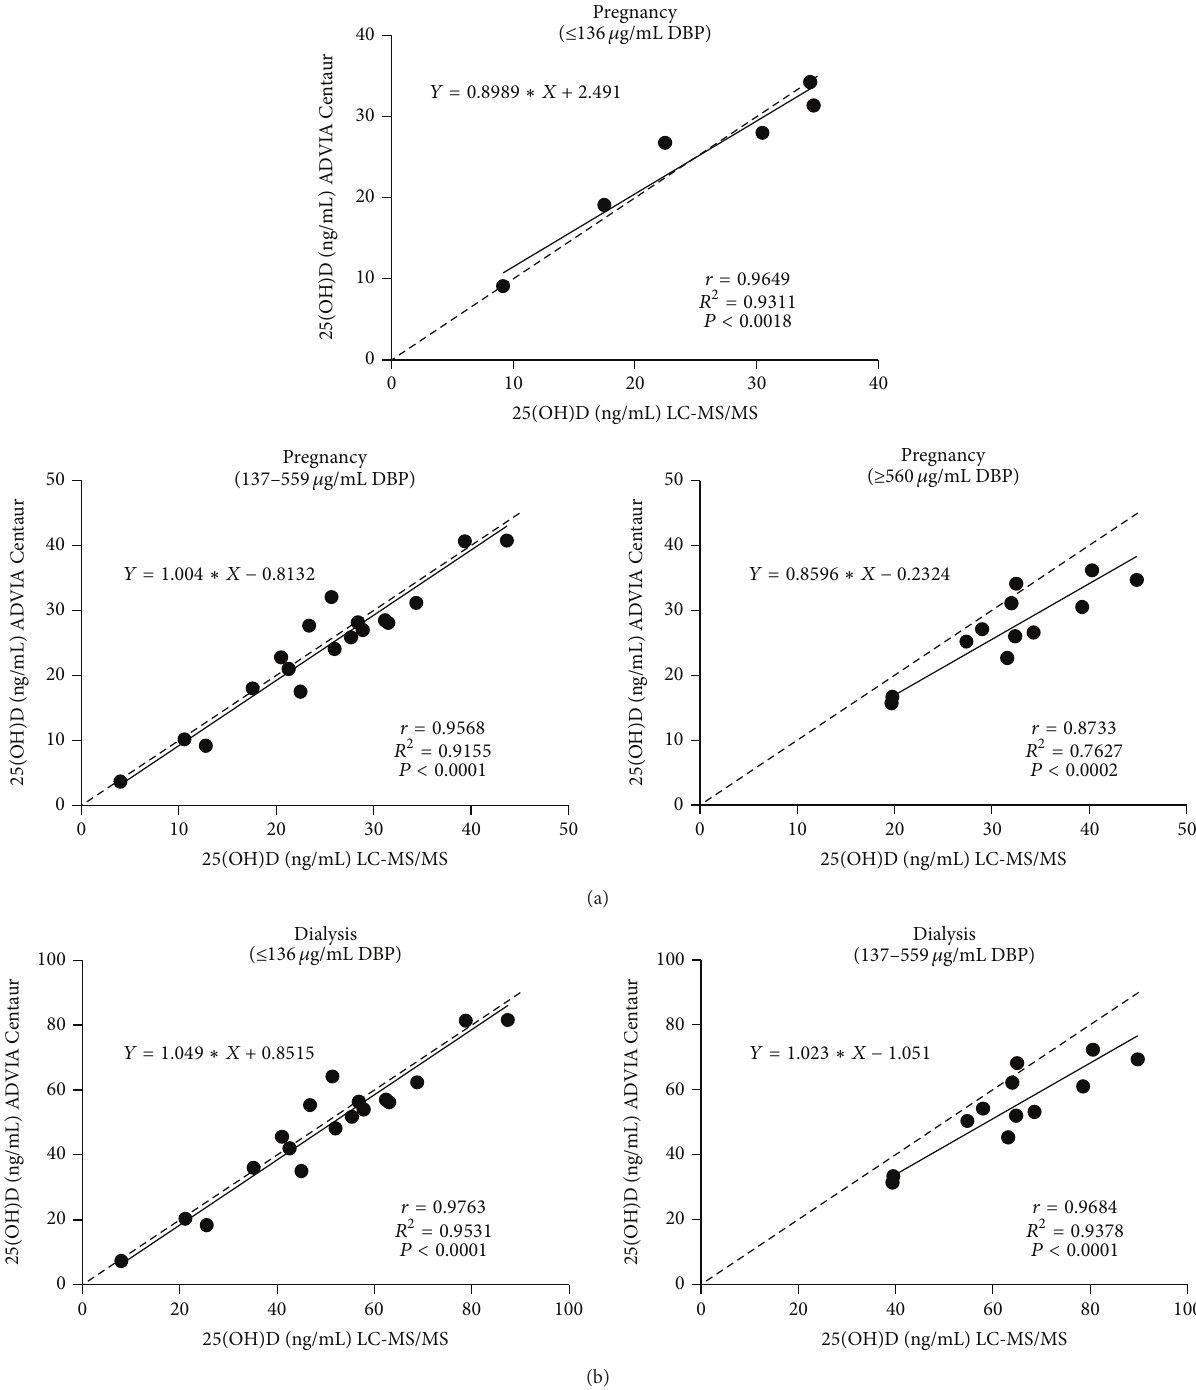
Figure 4: Correlation of 25(OH)D results obtained from the ADVIA Centaur Vitamin D Total assay and the LC-MS/MS method for (a) pregnancy (third trimester) samples and (b) renal dialysis samples. Dotted line: line of identity. To convert 25(OH)D concentrations to nanomoles per liter (nmol/L), multiply by